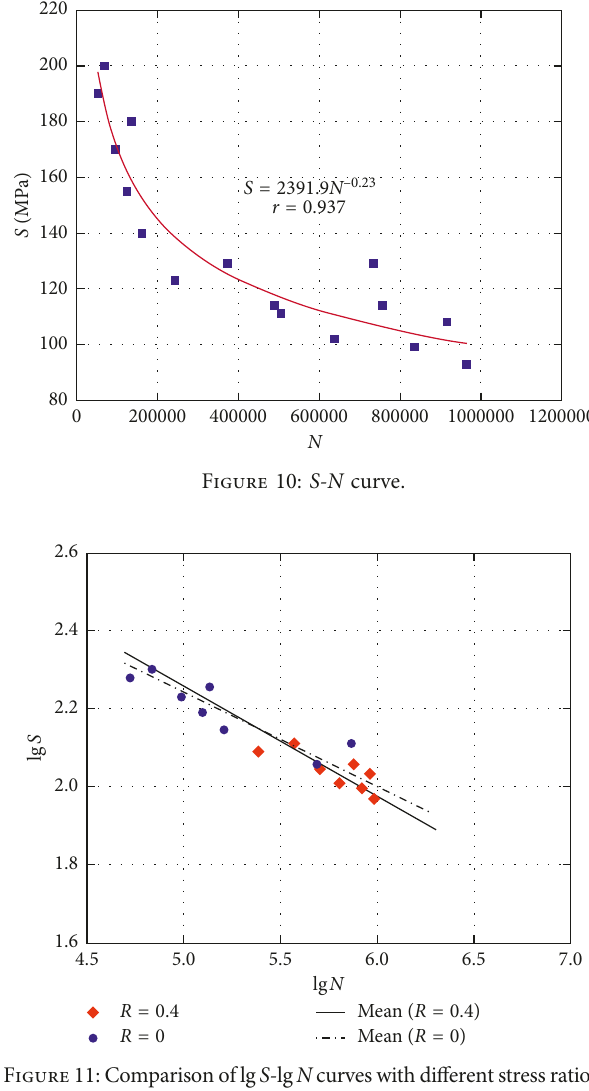
Figure 11: Comparison of lg S -lg N curves with different stress ratios.